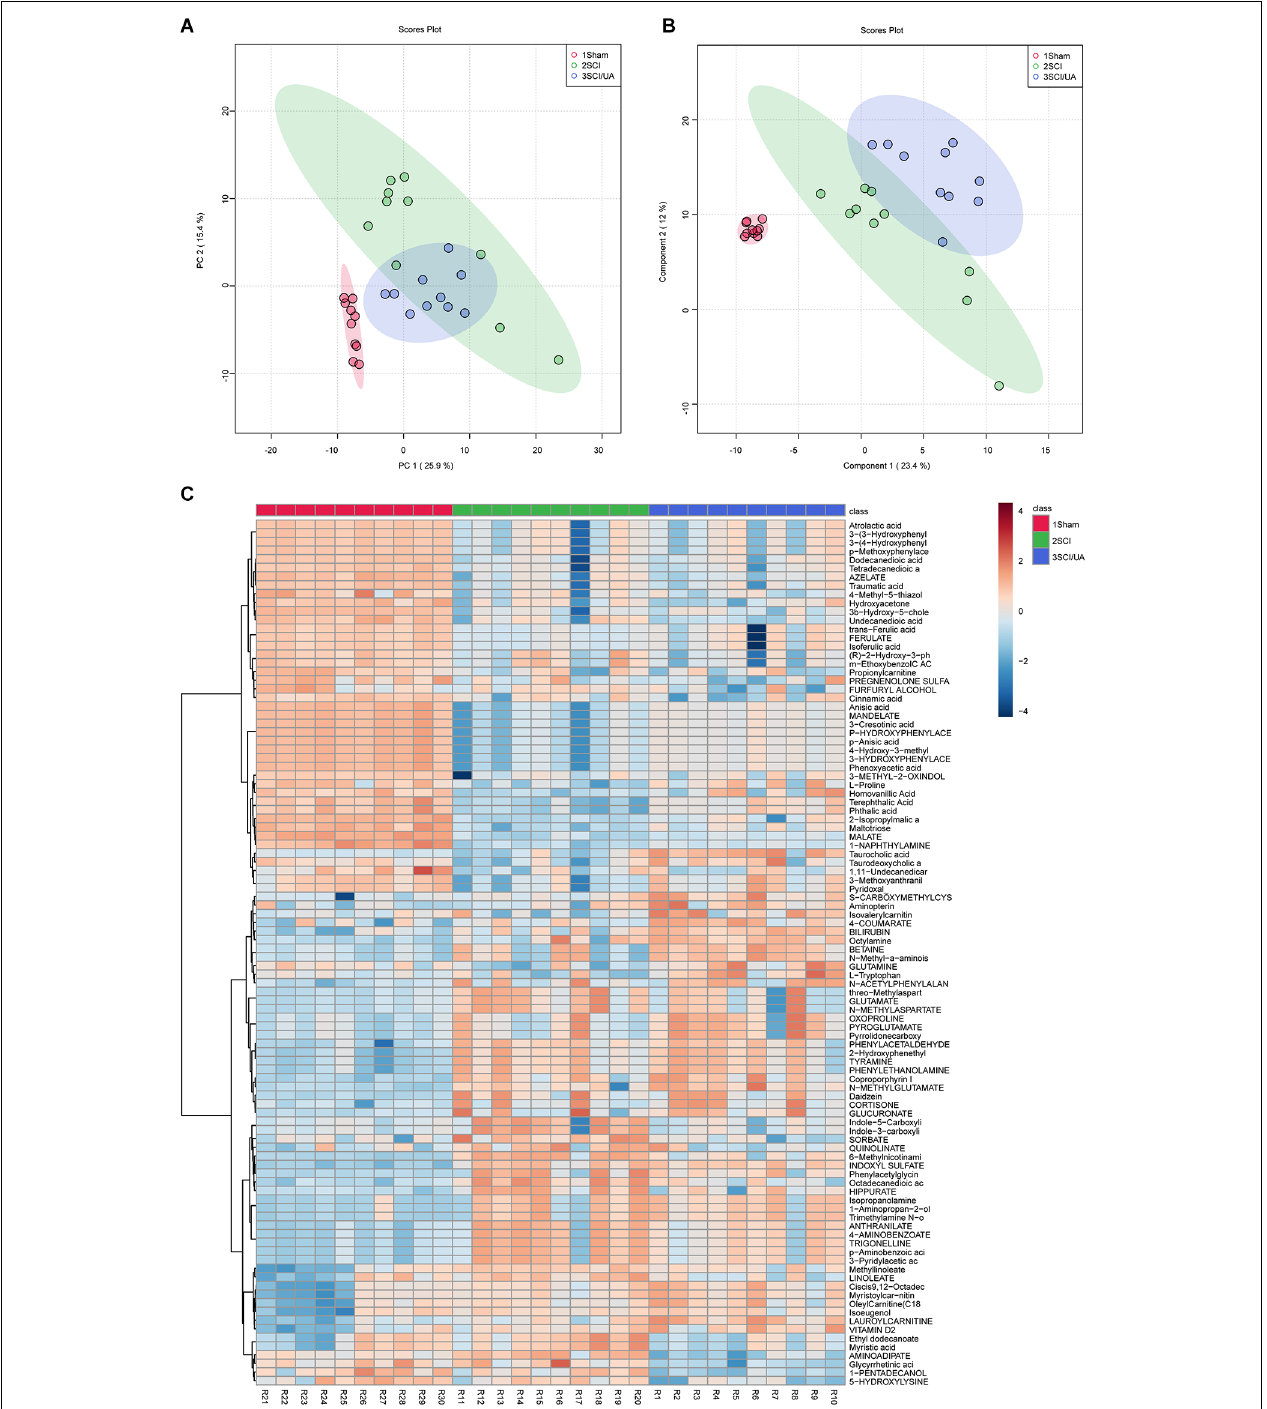
FIGURE 5 | UA regulated gut metabolism in SCI mice. (A) PCA and (B) PLS-DA was performed for dimension reduction analysis of metabolites in mice. (C) The heatmap showed the top 100 metabolites.